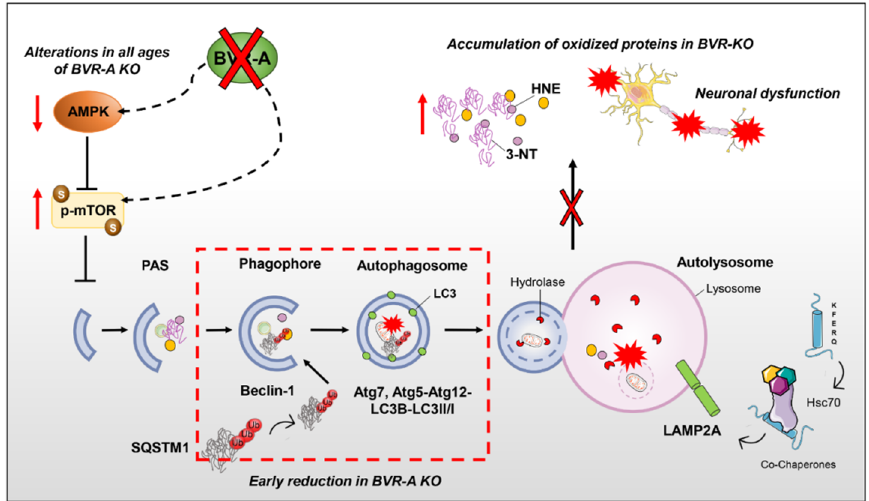
Figure 7. Schematic representation of the autophagosome nucleation / maturation process with highlighted the proposed role for BVR-A in regulating the AMPK / mTOR axis. Under pathological conditions, the hyper-activation of mTOR, mediated by the phosphorylation of serine 2448, is responsible for autophagy inhibition. mTOR activation is maintained within a physiological range by AMPK, that during conditions of reduced energy supply is known to inhibit mTOR, thus favouring the autophagy process. BVR-A deficiency is associated with an early mTOR hyper-activation along with a drastic impairment of AMPK, suggesting the presence of a regulatory axis formed by BVR-A / AMPK / mTOR. In the proposed scenario, we highlight alterations at di ff erent steps of the autophagy machinery. In details, autophagosome formation, elongation process and autolysosomal degradation are impaired as indexed by the reduction of Beclin-1, LC3 β , LC3II / I ratio Atg5–Atg12 complex and Atg7 levels. Furthermore, alterations of SQSTM1 (sequestosome-1) levels also suggest an early impairment of cargo’s transport into the autophagosome, a ff ecting the clearance of poly-ubiquitinated proteins. As results of impaired autophagy in the brain, an increased accumulation of oxidatively-damaged proteins (HNE and 3-NT) in the brain of BVR-A − / − mice occurs. The failure of autophagic flux further exacerbates the build-up of neurotoxic aggregates, triggering a vicious cycle that gradually results in neuronal dysfunction. Red dashed lines underline early altered steps of autophagy in BVR-A − / − mice.